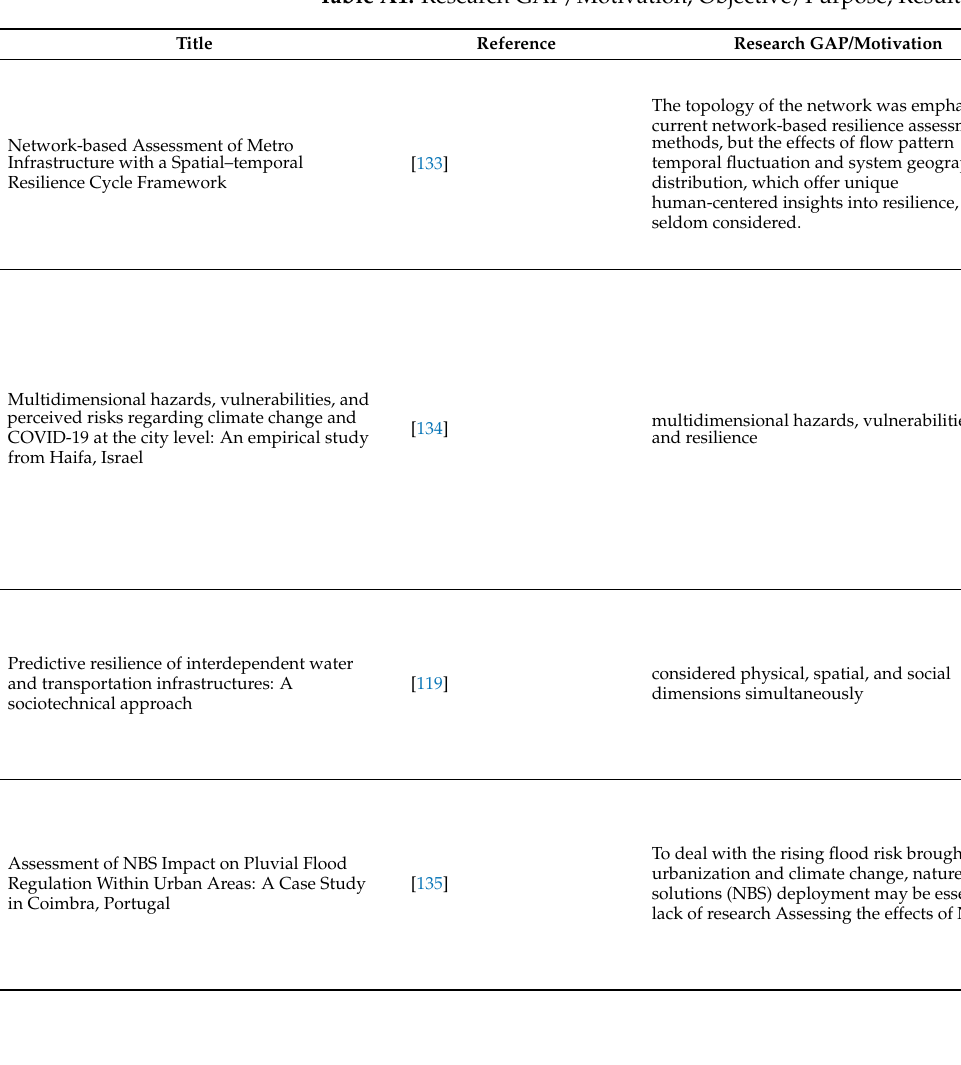
Table A1. Research GAP/Motivation, Objective/Purpose, Result/Output of reviewed